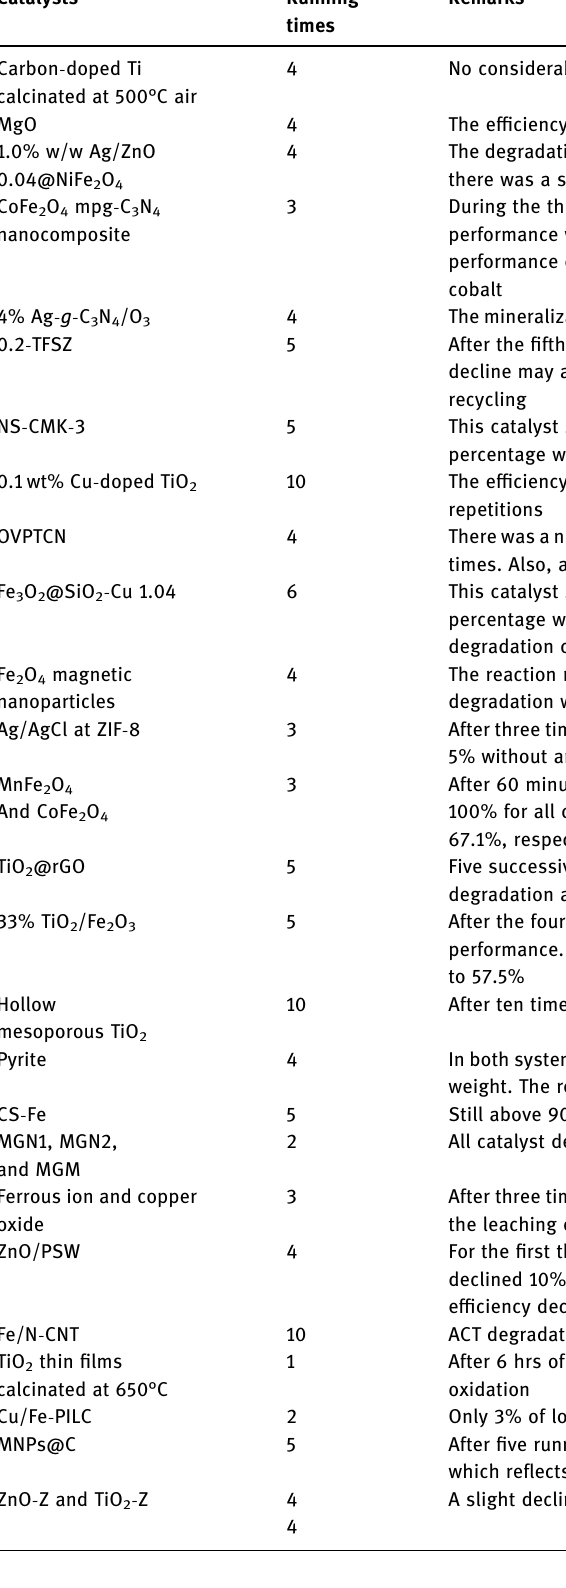
Table 5: Summary of the studies that applied degradation cycles to examine the durability of the catalysts